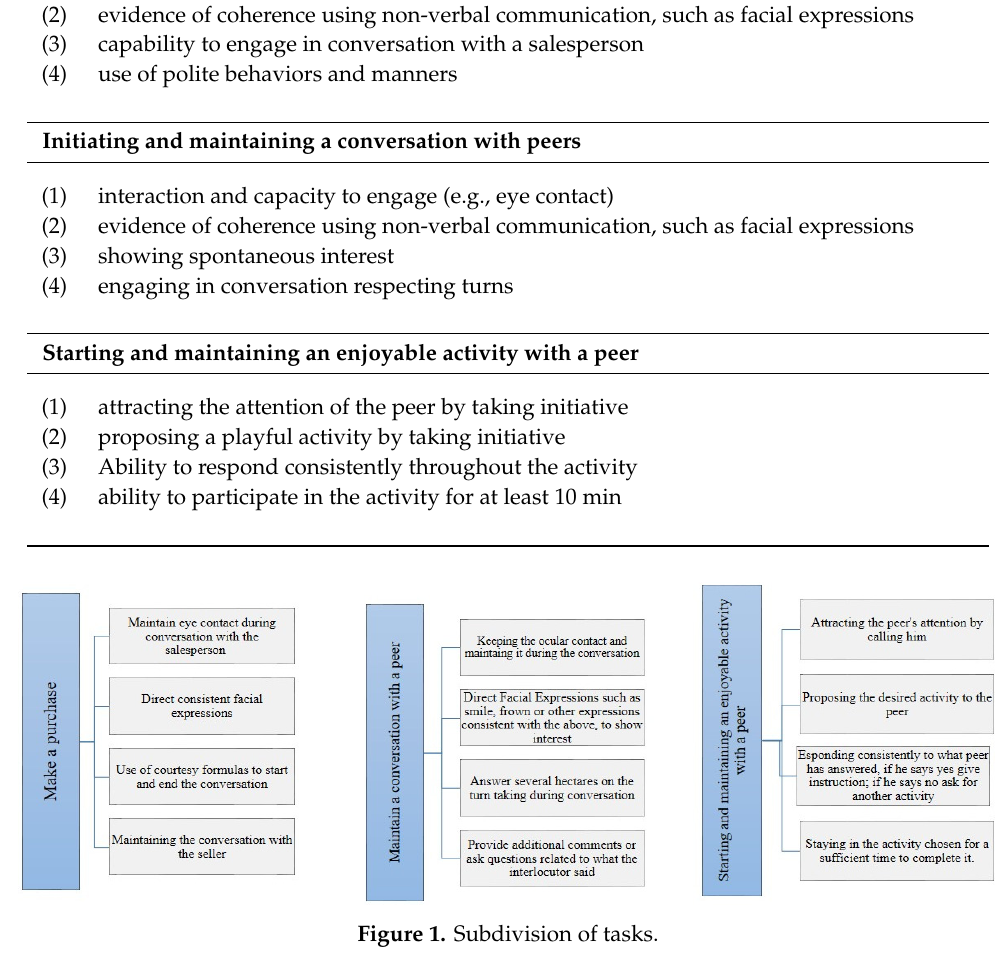
Table 2. Subdivision of tasks .